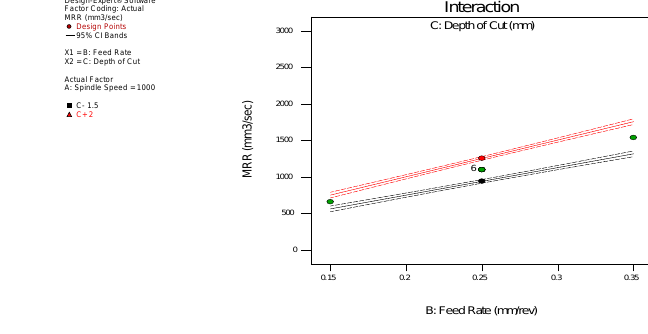
Fig. 8. Interaction plot for MRR vs Feed rate and depth of cut